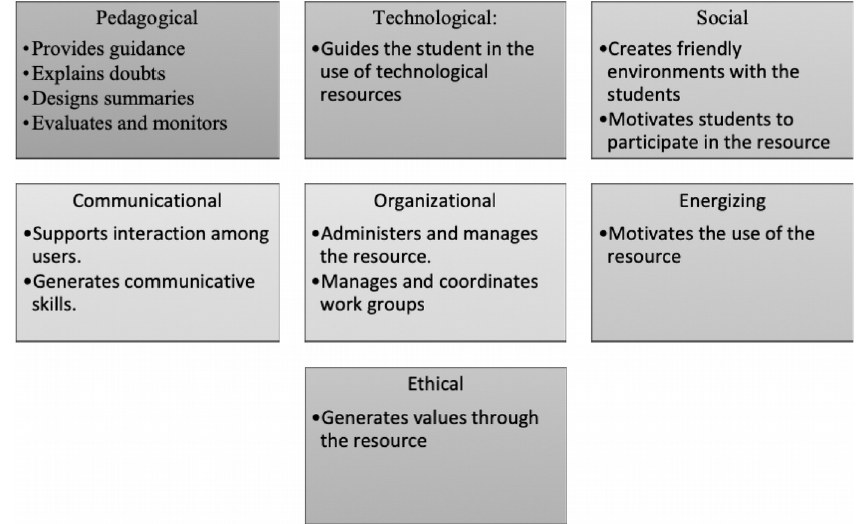
Figure 5. Virtual tutor competences according to Ortega